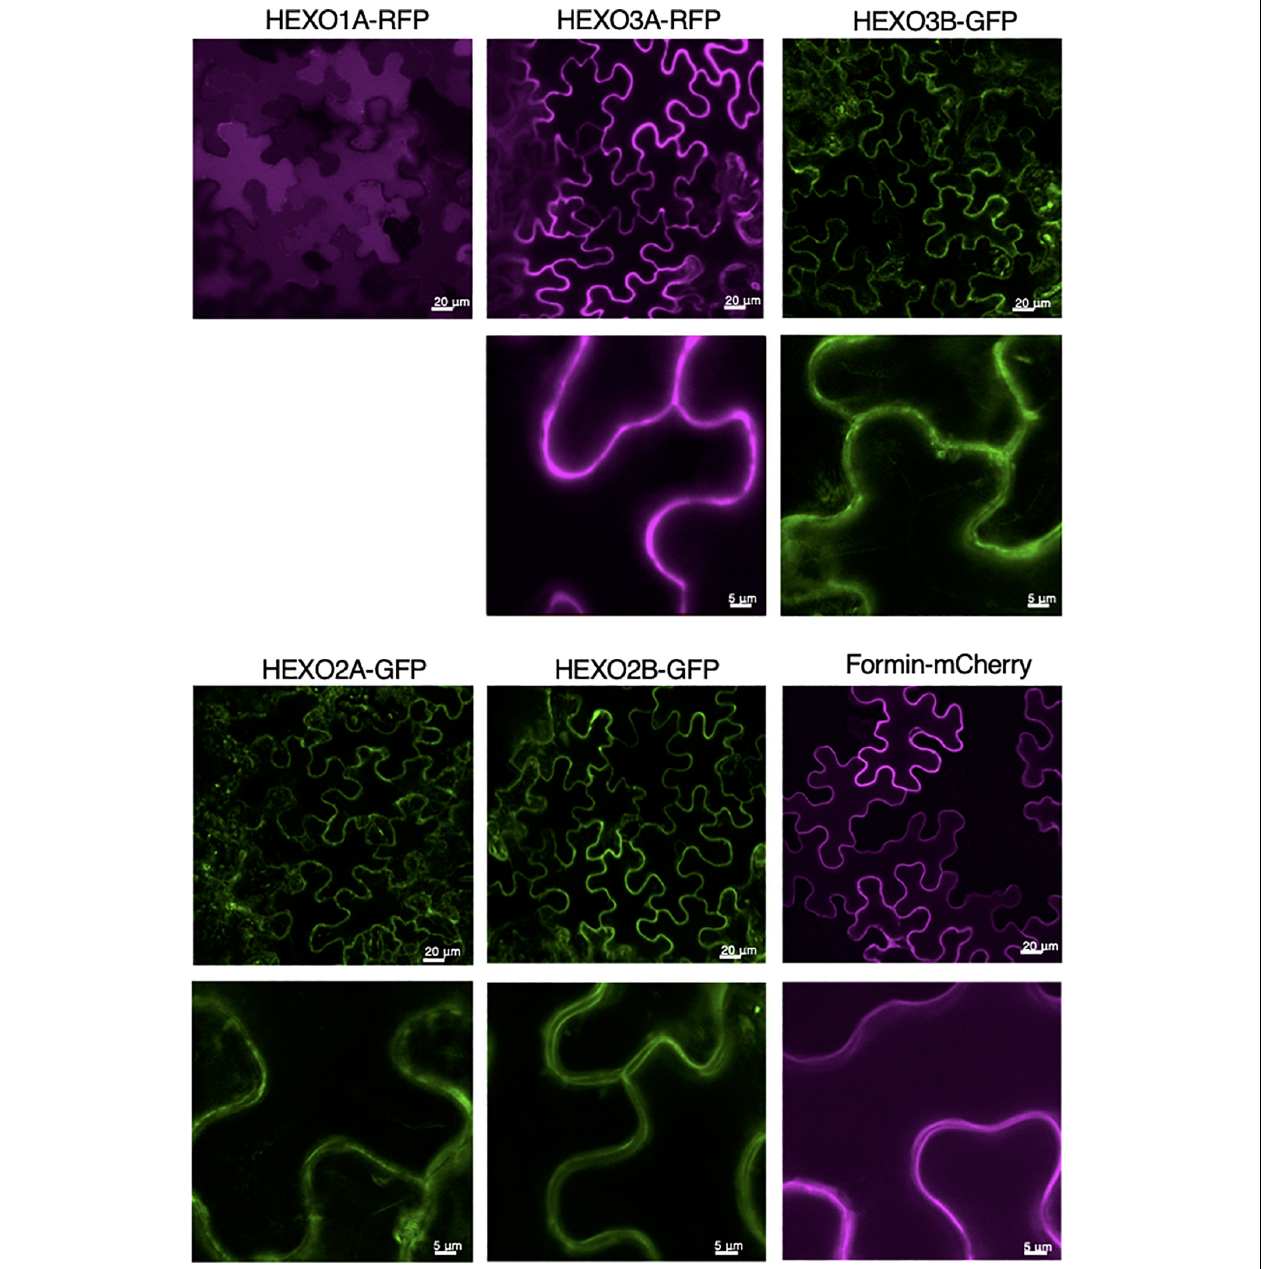
FIGURE 3 | Subcellular localization of Nicotiana benthamiana HEXOs. GFP- or RFP-tagged HEXOs or formin-mCherry (used as plasma membrane marker) were transiently expressed in N. benthamiana leaves. Whole mount confocal microscopy pictures were taken at 3 days post infiltration. For each construct overview pictures are given (scale bar of 20 µ m) and a picture at higher magnification underneath (scale bar 5 µ